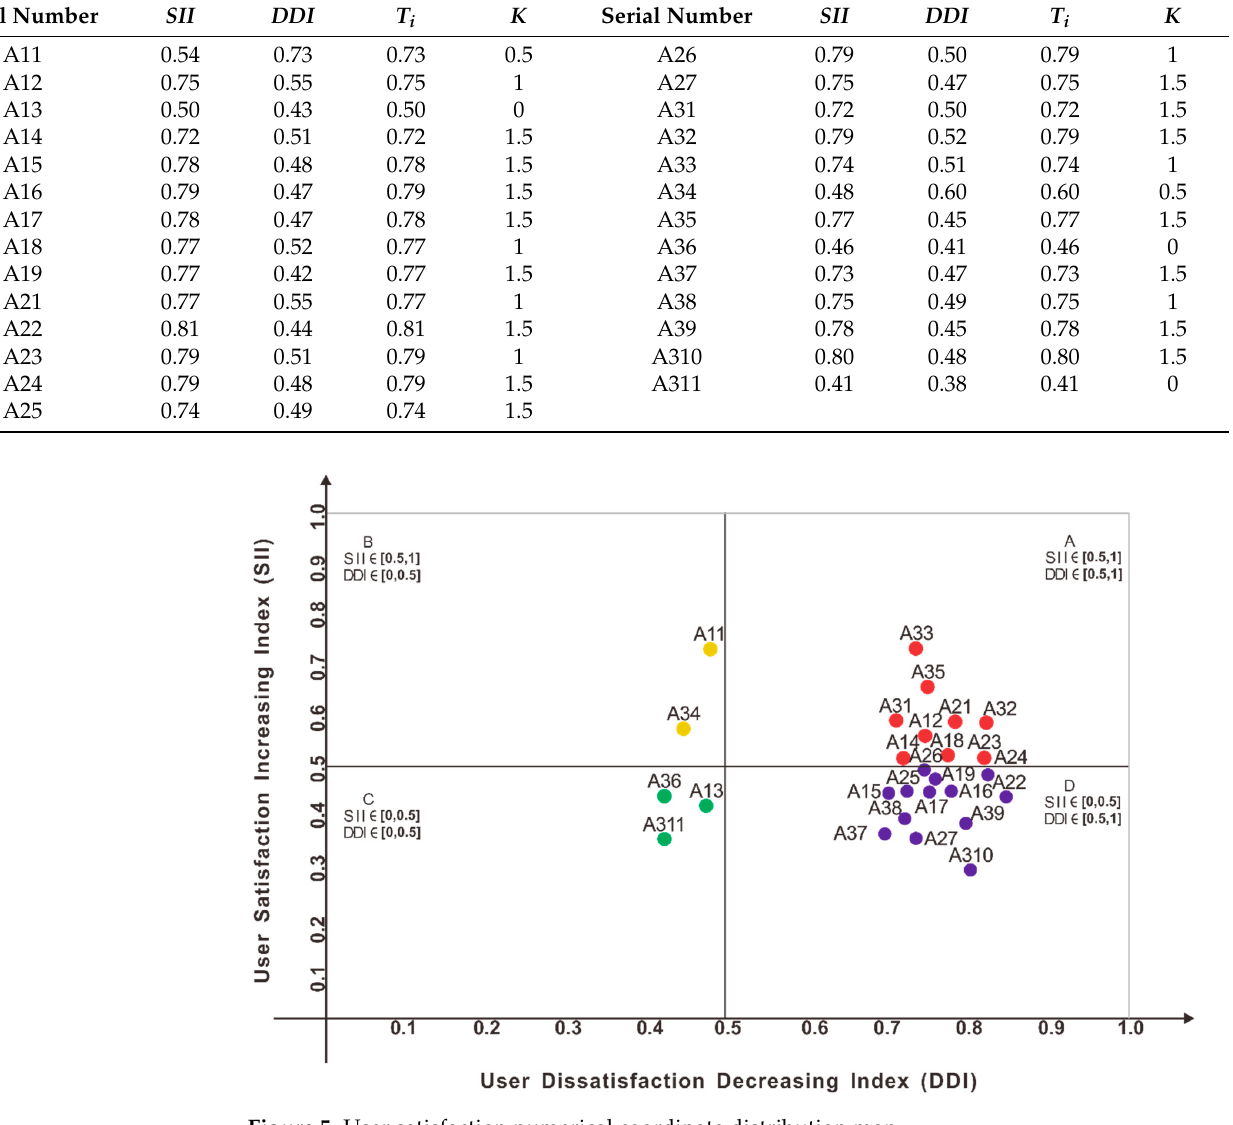
Figure 6. Demand degree comprehensive evaluation results. Table 6. Hierarchy of design requirements. First-Level Serial Number